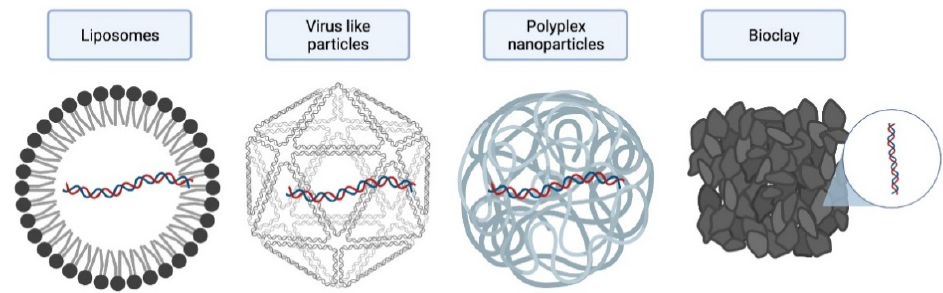
Figure 2. Primary encapsulation system for RNAi delivery.